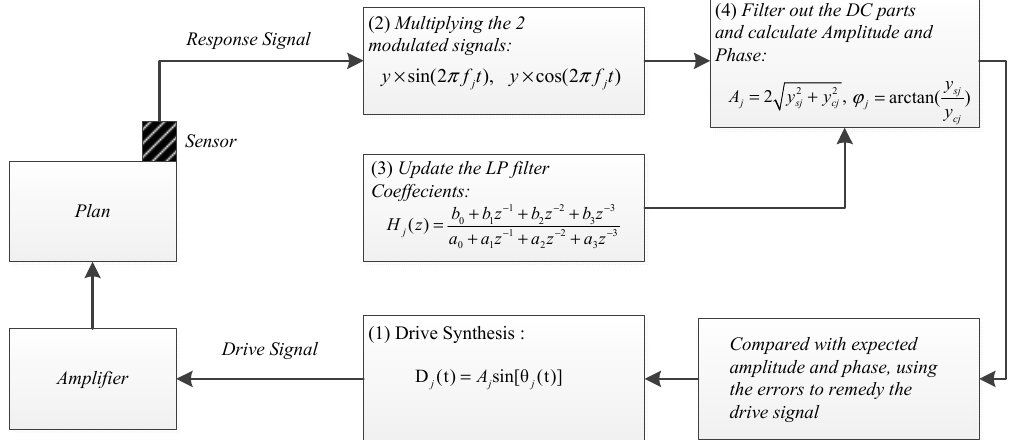
Figure 3. The flowchart of branch j in parallel tracking filters.